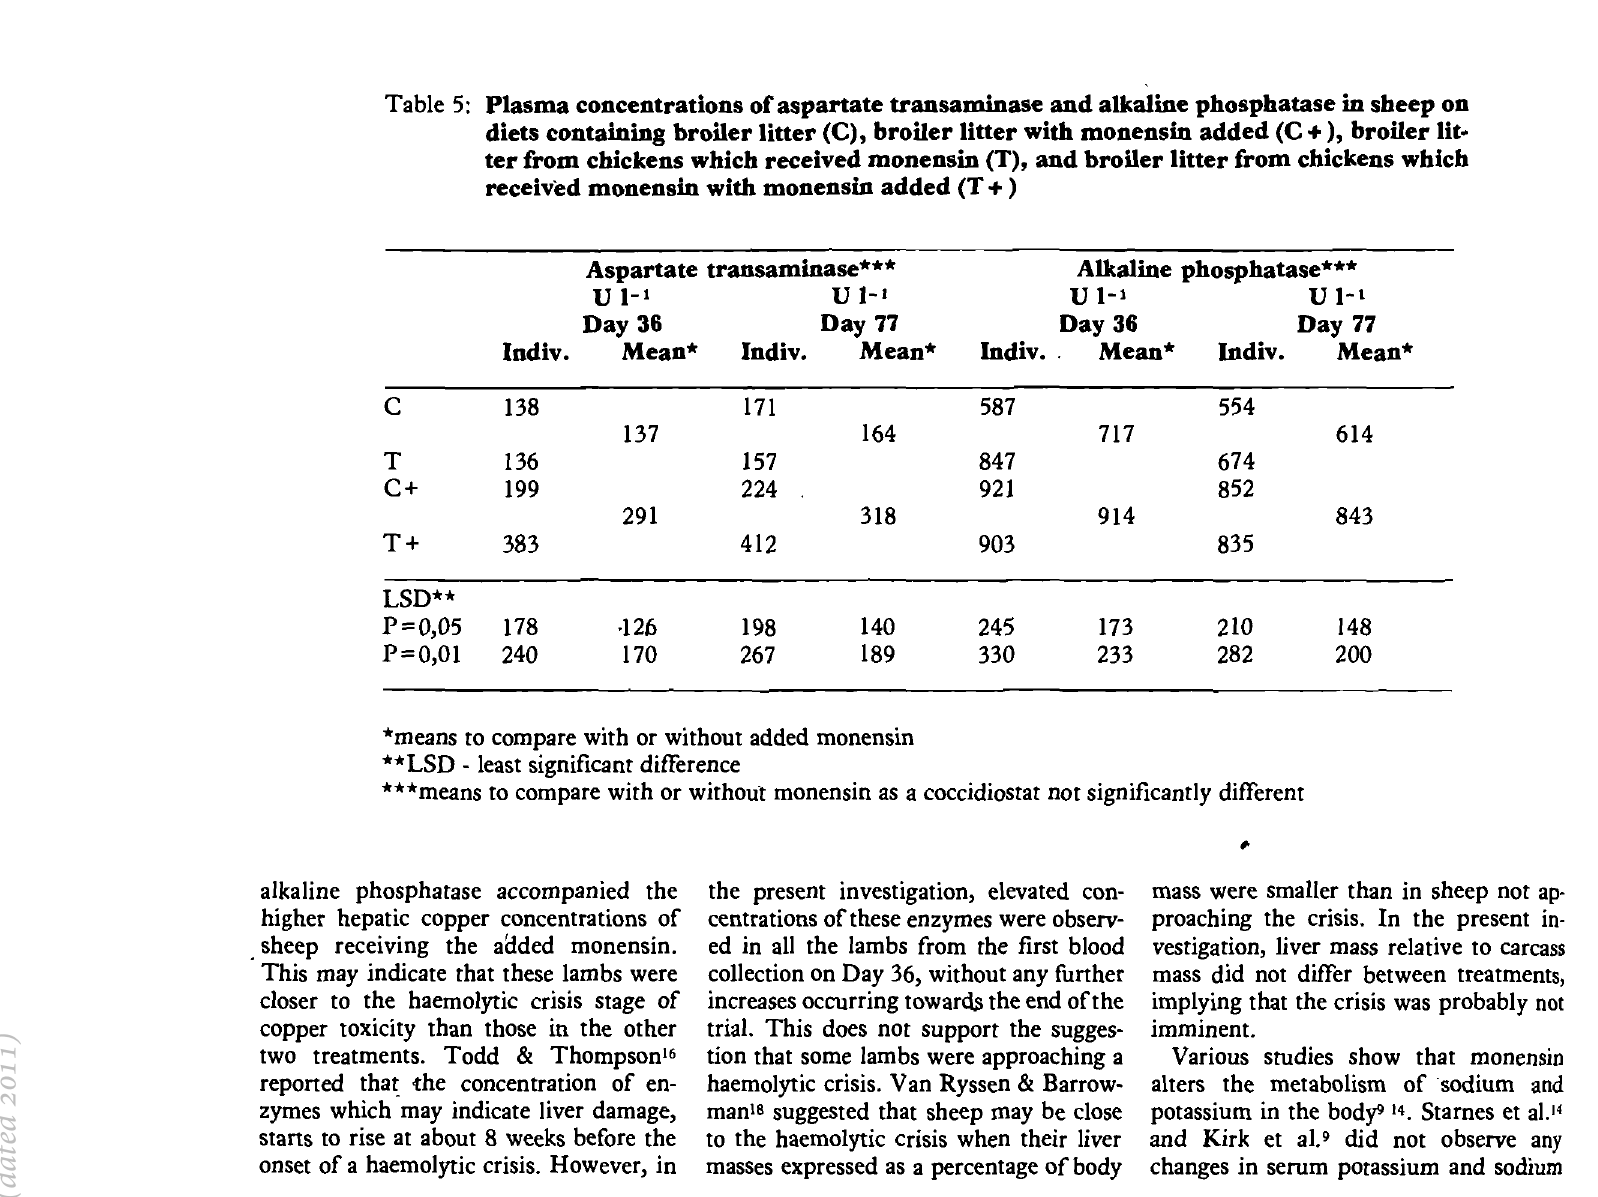
Table 6: Hepatic copper concentrations in sheep which were fed broiler litter (C), broiler litter with monensin added (C + ), broiler litter from chickens which rec~ived monensin (T), and broiler litter from chickens which received monensin with monensin added (T +